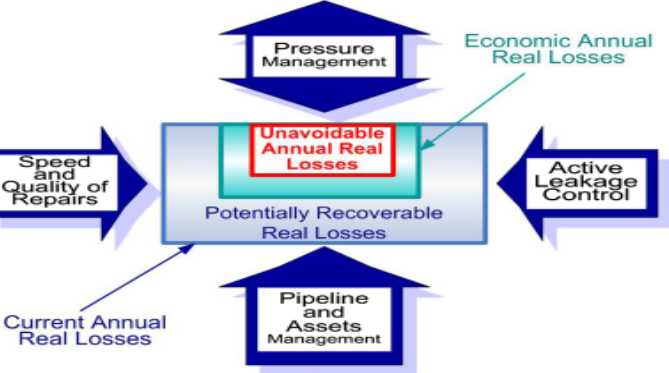
Figure 3. Water losses reduction strategies